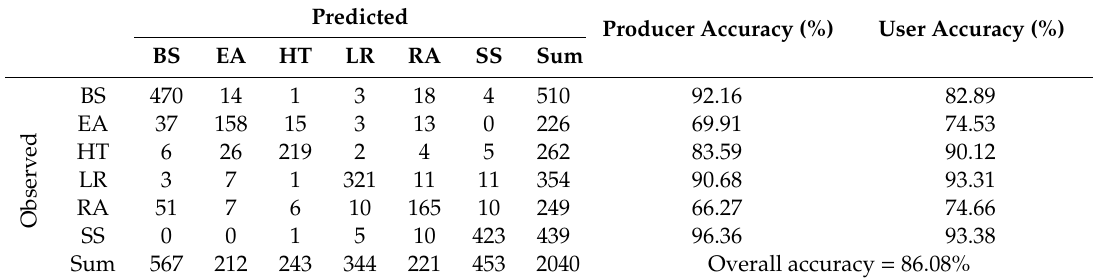
Table 6. Accuracy of mangrove species classification at individual tree level.